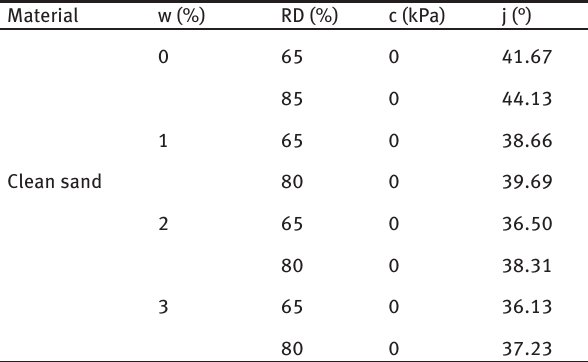
Table 4: Cohesion and friction angle for test result.